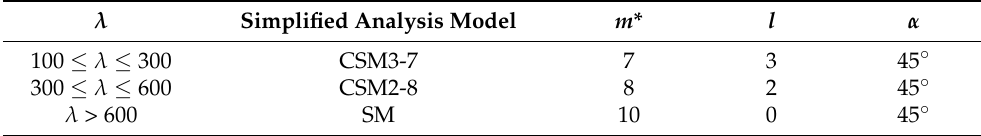
Table 1. Parameters of simplified analysis model of steel plate shear wall (SPSW). λ